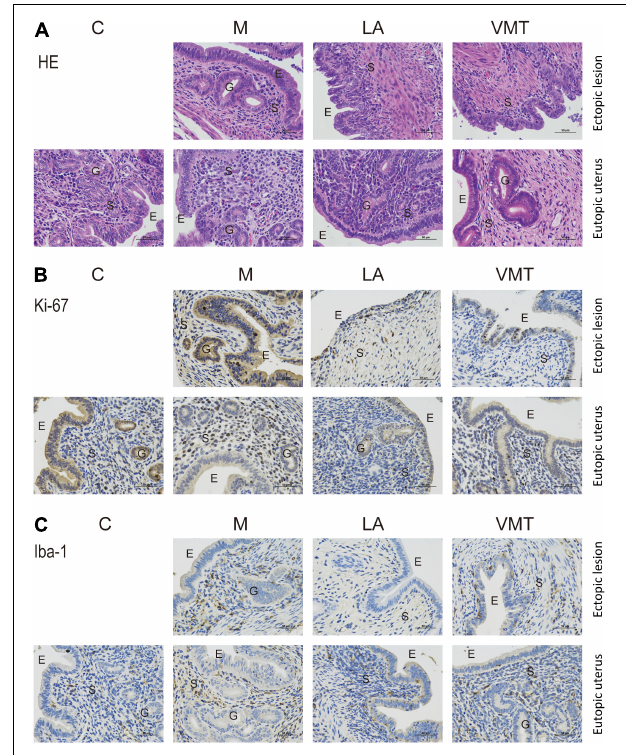
FIGURE 6 | VMT inhibits endometriotic lesion progression confirmed by pathological examination. (A) Representative hematoxylin and eosin-stained cross-section images of the eutopic uteri and ectopic lesions from the indicated treatment groups. The scale bar (0.5 µ m) applies to all images. (B,C) Representative cross-sectional images of the eutopic uteri and ectopic lesions immunohistochemistry stained for Ki-67 (B) and Iba1 (C)